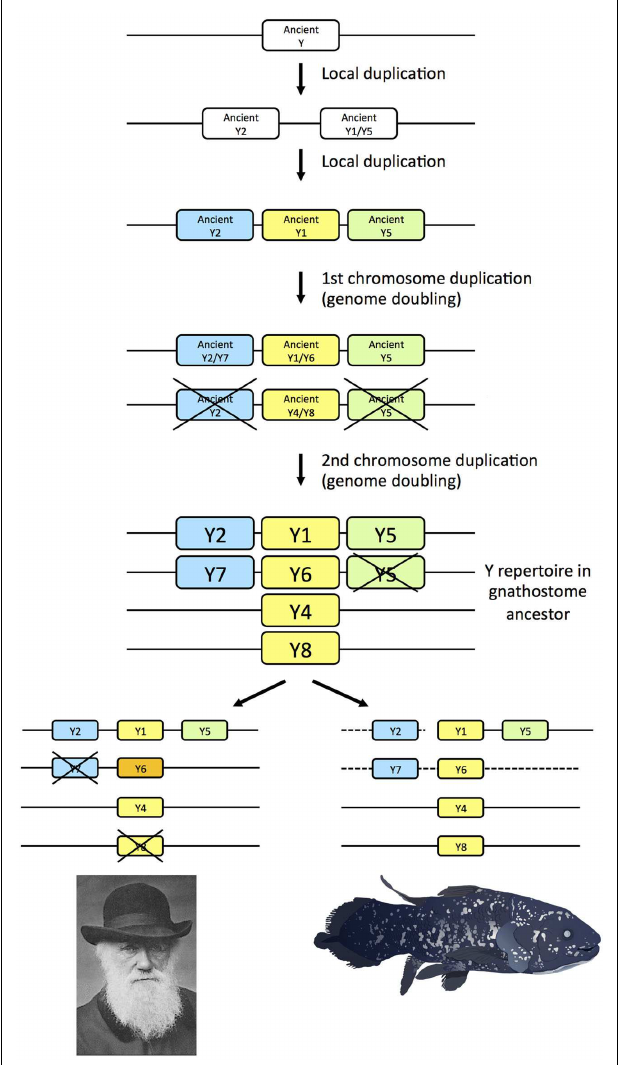
FIGURE 6 | Gene duplication events for the NPY receptor family in early vertebrate evolution including the two basal tetraploidizations. Crosses mark gene losses.The humanY6 gene is a pseudogene, as indicated by orange color.The dashed lines for the coelacanth indicate that it is not known if the genes are